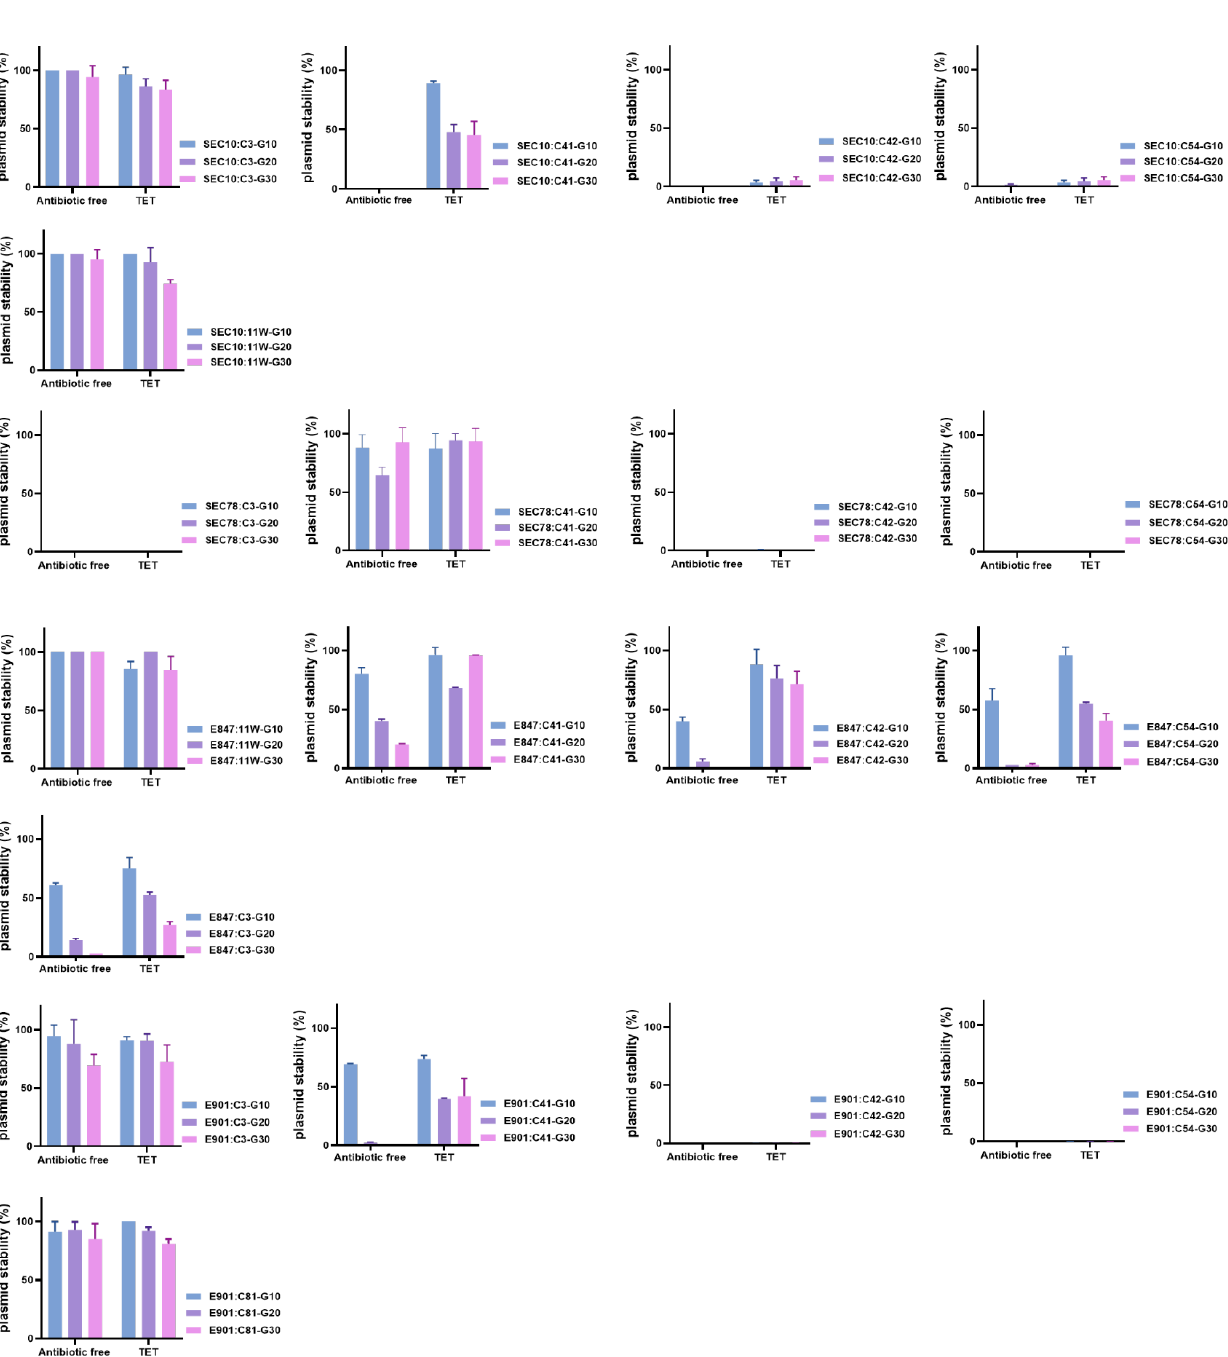
Figure 4. Stability of tet (X4)-bearing plasmids in the transformants of different generations. ( A ): Transformants of TOP10; ( B ): transformants of SEC10; ( C ): transformants of SEC78; ( D ): transformants of E847; ( E ): transformants of